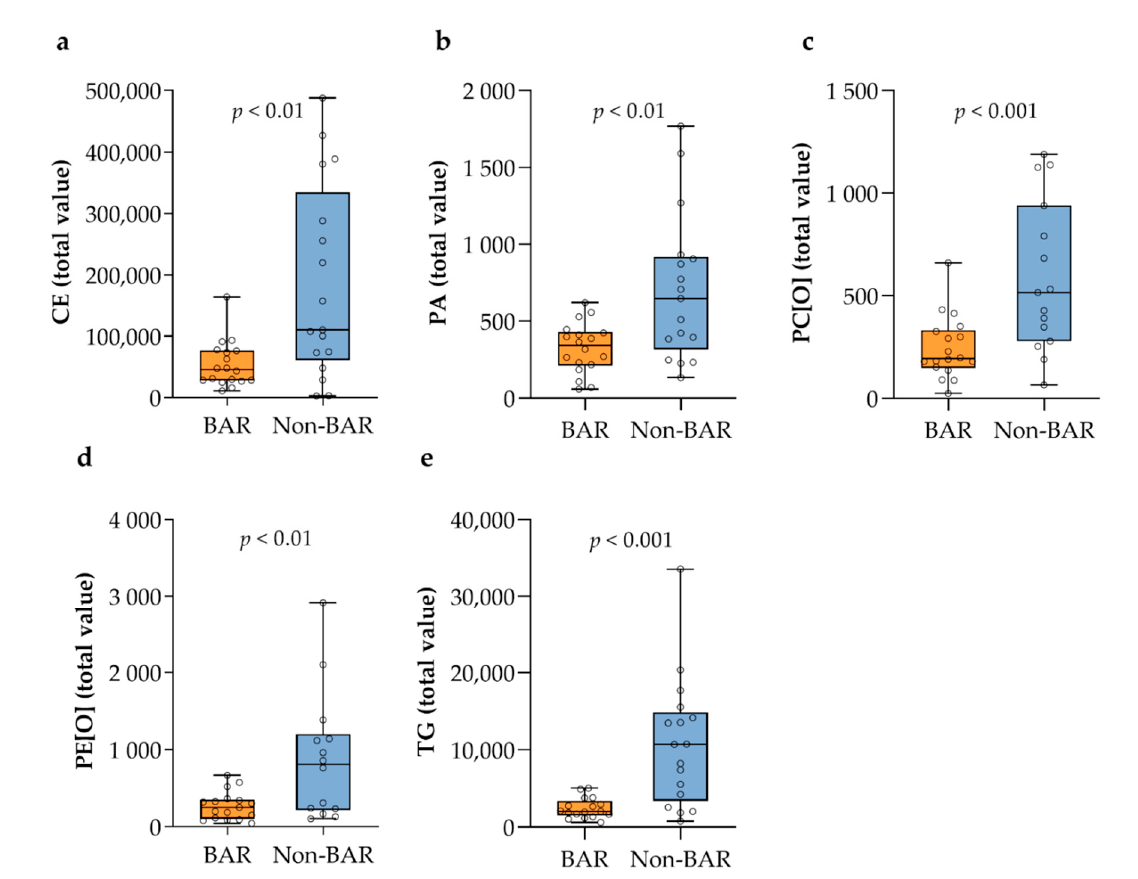
Figure 3. Total lipid levels in gallbladder bile sorted by lipid class that differed significantly between the groups: ( a ) cholesterylester; ( b ) phosphatidic acid; ( c ) alkyl-phosphatidylcholine; ( d ) alkyl-phosphatidylethanolamine; ( e ) triglyceride.